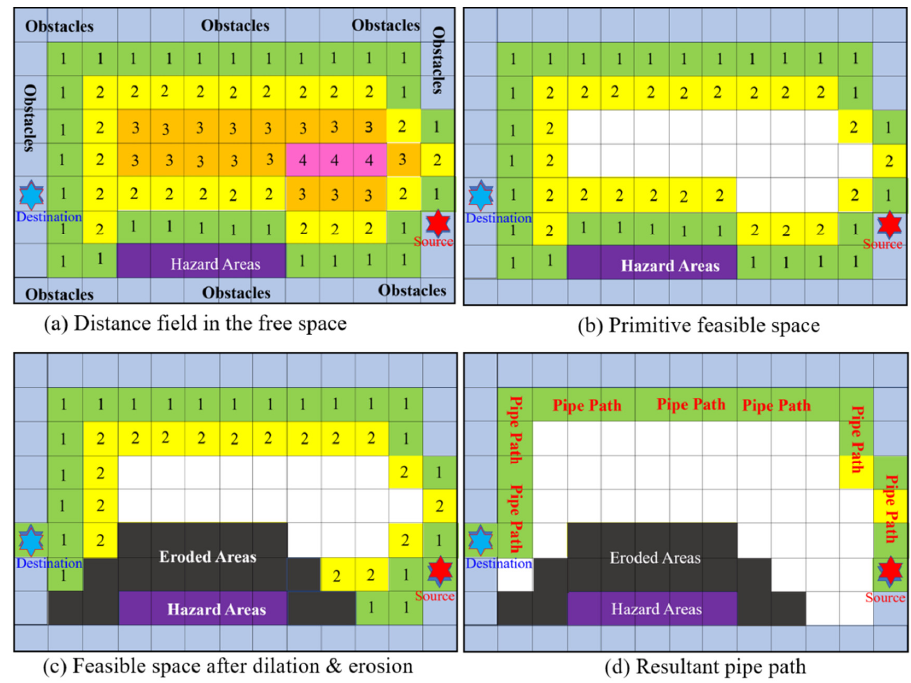
Figure 3. A 2D example illustrating the construction and variation of the feasible space, ( a ) the free space, ( b ) the primitive feasible space, ( c ) the final feasible space, ( d ) the pipe path composed of